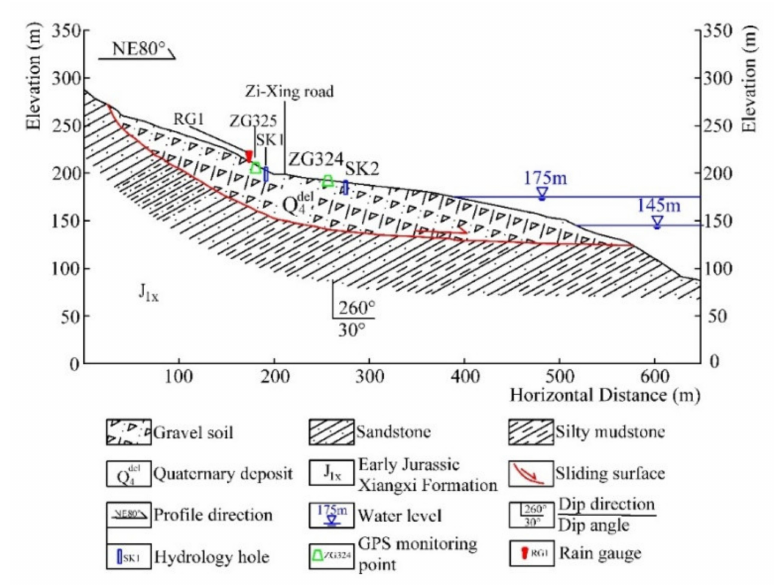
Figure 7. Schematic geological cross-section A–1 (cid:48) of the Baijiabao landslide.